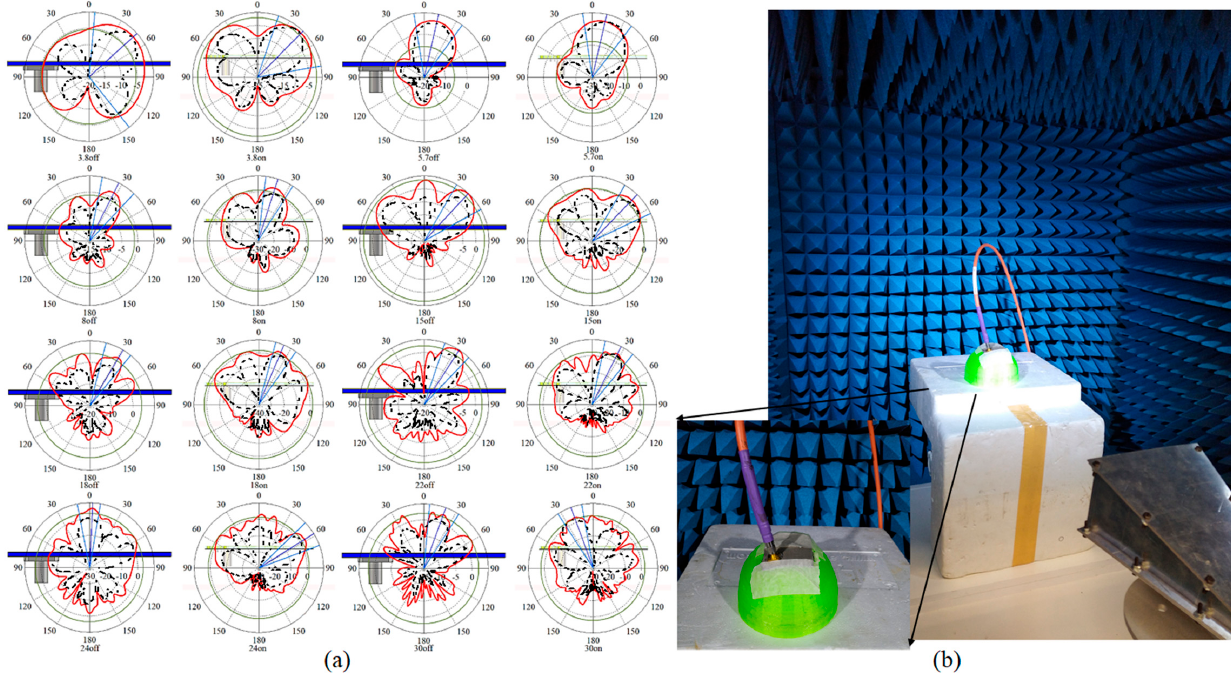
Figure 6. ( a ) Radiation pattern of the antenna at different frequencies on-body (breast phantom) and off-body (solid line: simulated, dashed line: measured) and ( b ) radiation measurement setup on breast phantom.